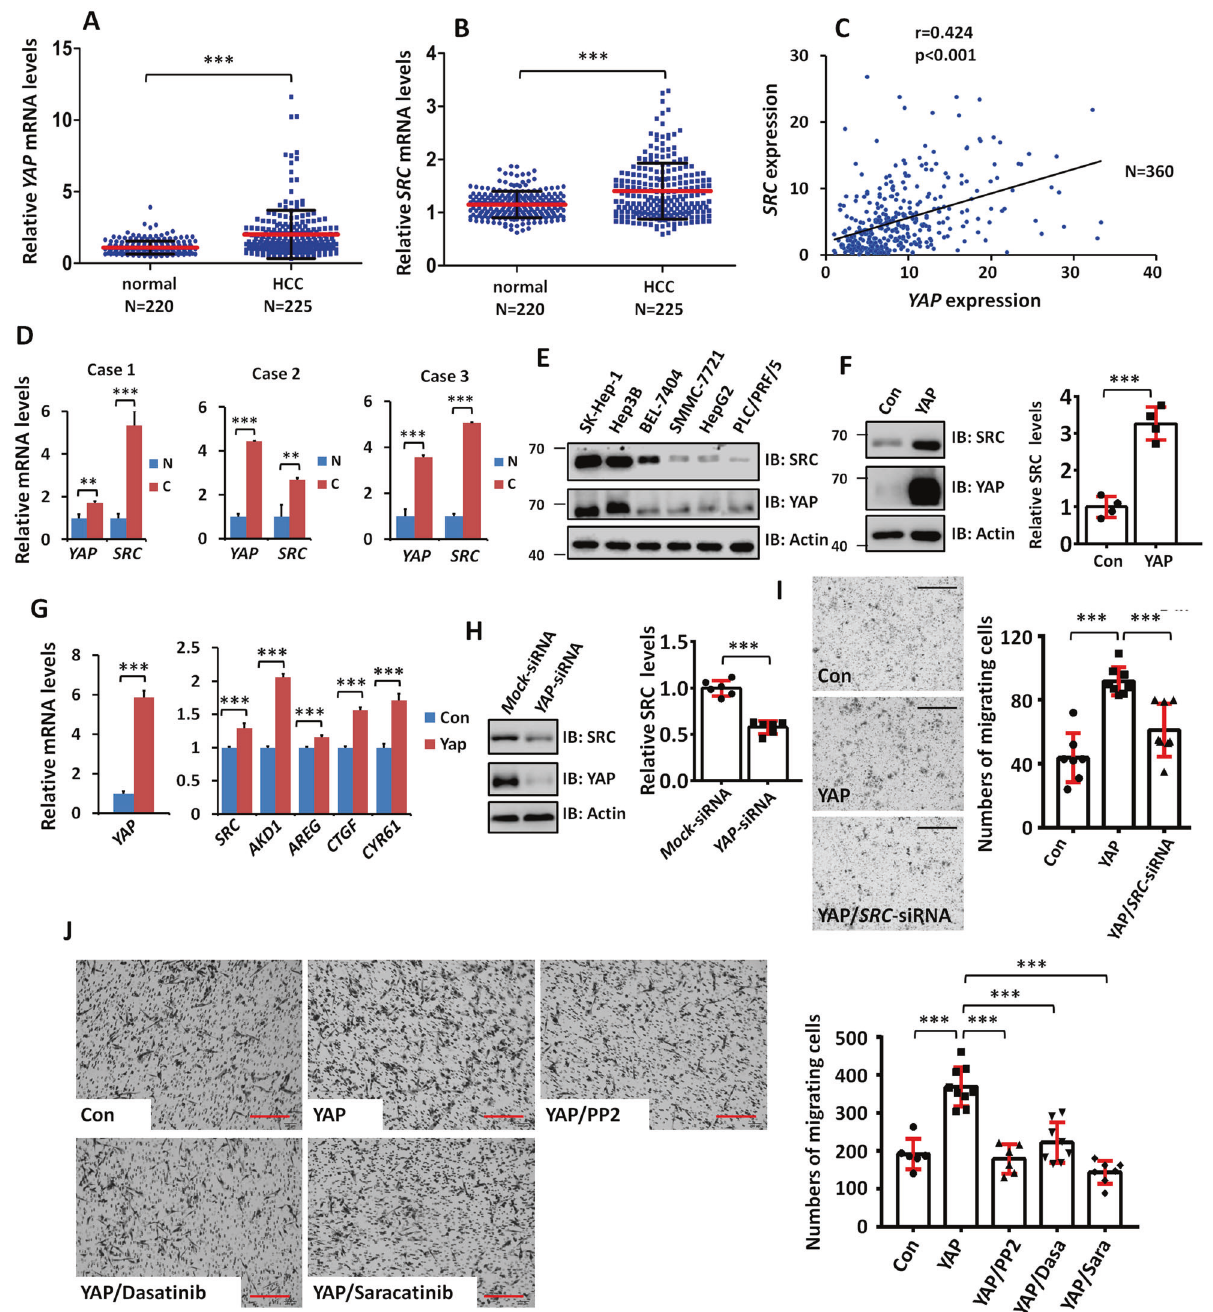
Fig. 6 YAP promotes HCC cell migration through SRC. A Comparison of normal liver tissues ( N = 220) with HCC samples ( N = 225) showed upregulation of YAP mRNA in HCC samples. B The expression of SRC was increased in HCC samples. C Correlation analysis of SRC and YAP expression in HCC samples ( N = 360) revealed positive correlation between SRC and YAP . D RT-qPCR analyses showed upregulation of YAP and SRC expression in clinical HCC samples. E Immunoblots (IBs) analyses for protein levels of YAP and SRC in six HCC cell lines. PLC/PRF/5 cells showed minimum expression of SRC and YAP. Actin acts as a loading control. F Transfection of YAP increased SRC protein in PLC/PRF/5 cells. Actin serves as a loading control. Quanti fi cation was shown on the right. G RT-qPCR analyses showed YAP-dependent upregulation SRC mRNA level in PLC/PRF/5 cells. AKD1 , AREG , CTGF , and CYR61 are well-known YAP targets and used as positive controls. H Knockdown of YAP downregulated SRC protein level in PLC/PRF/5 cells. Actin serves as a loading control. Quanti fi cation was shown on the right. I Transwell analyses showed that YAP promoted PLC/PRF/5 cell migration, which was attenuated by SRC knockdown. Quanti fi cation was shown on the right. J The increased cell migration induced by YAP was suppressed by several SRC inhibitors in SK-Hep-1 cells. Quanti fi cation was shown on the right. Scale bars: 600 μ m for all